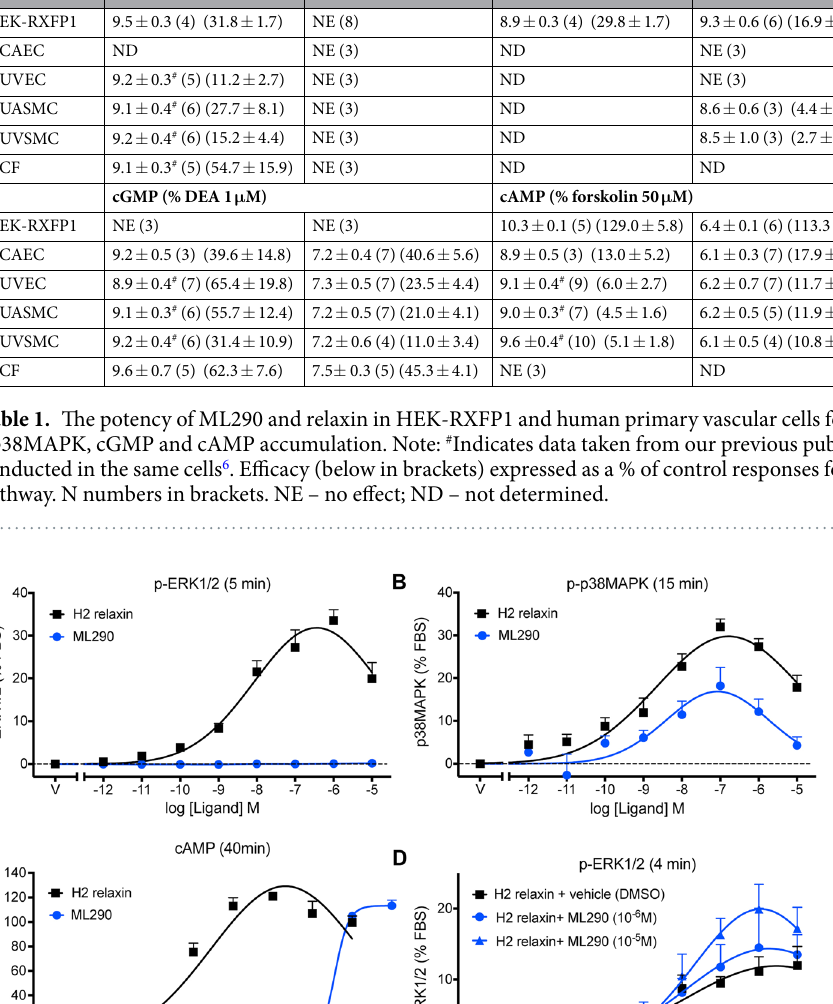
11.7 ± 3.9% in HUVECs (pEC 50 : 6.2 ± 0.7), 10.8 ± 3.0% in HUVSMCs (pEC 50 : 6.1 ± 0.5) and 11.9 ± 3.9% in HUASMCs (pEC 50 : 6.2 ± 0.5). ML290 was 3 orders of magnitude less potent than H2 relaxin (Table 1). ML290 did not cause cAMP accumulation in HUAEC (Fig. 4A), cells known not to express cell surface RXFP1 6 .